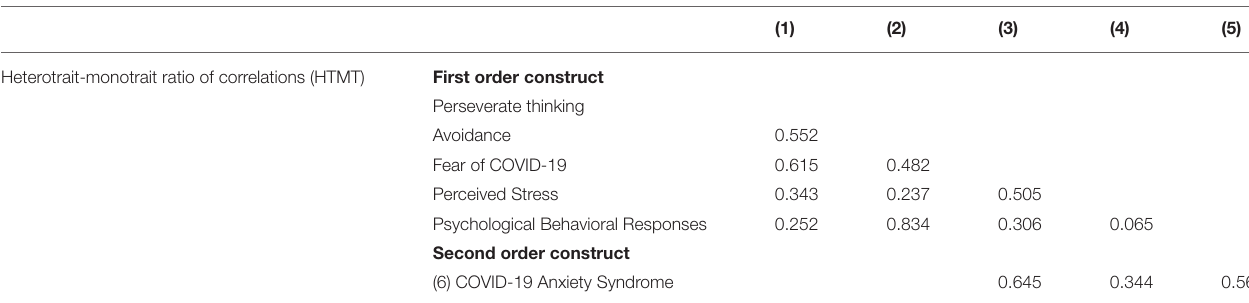
TABLE 3 | Discriminant validity assessment using HTMT